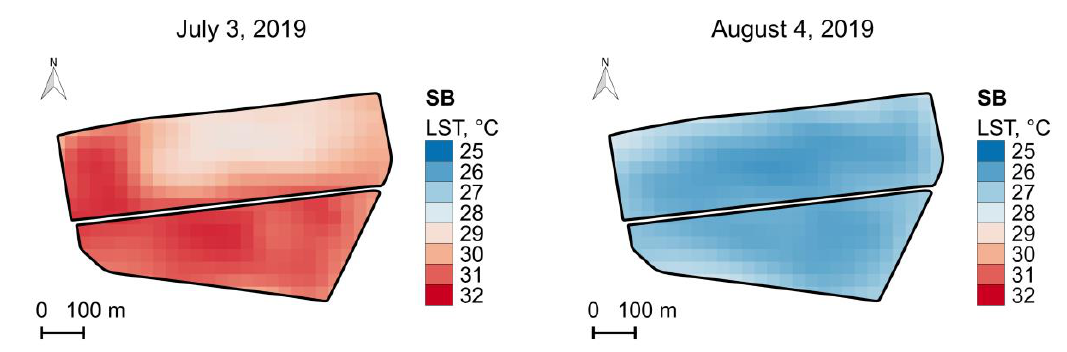
Figure 8. Temperature distribution over the experimental field derived with SB method for a dry ( left ) and wet ( right ) condition.